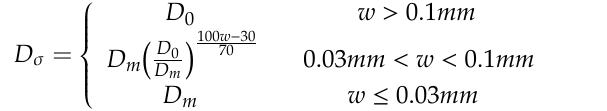
Figure 5. Materials 2020 , 13 , x FOR PEER REVIEW